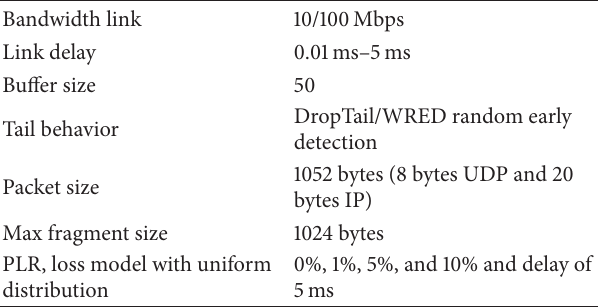
Table 5: Simulation